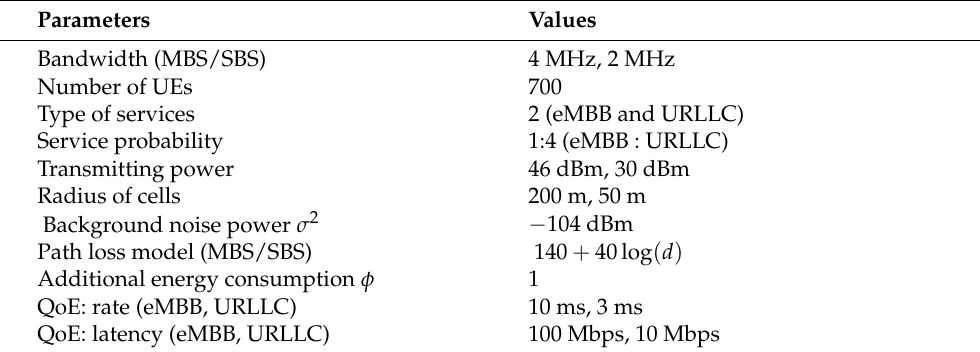
Table 2. Simulation parameters.